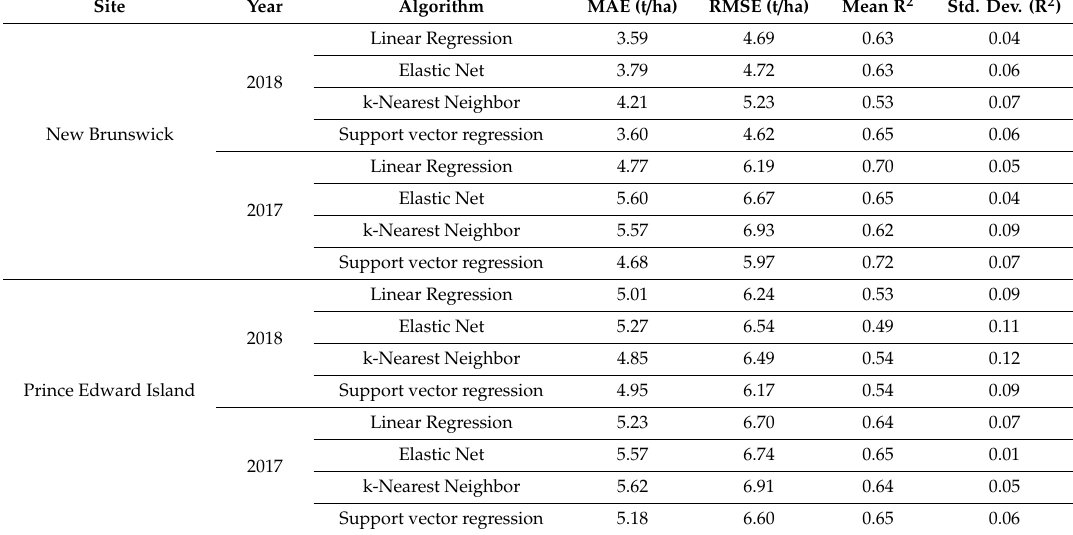
Table 4. Algorithm comparison of selected